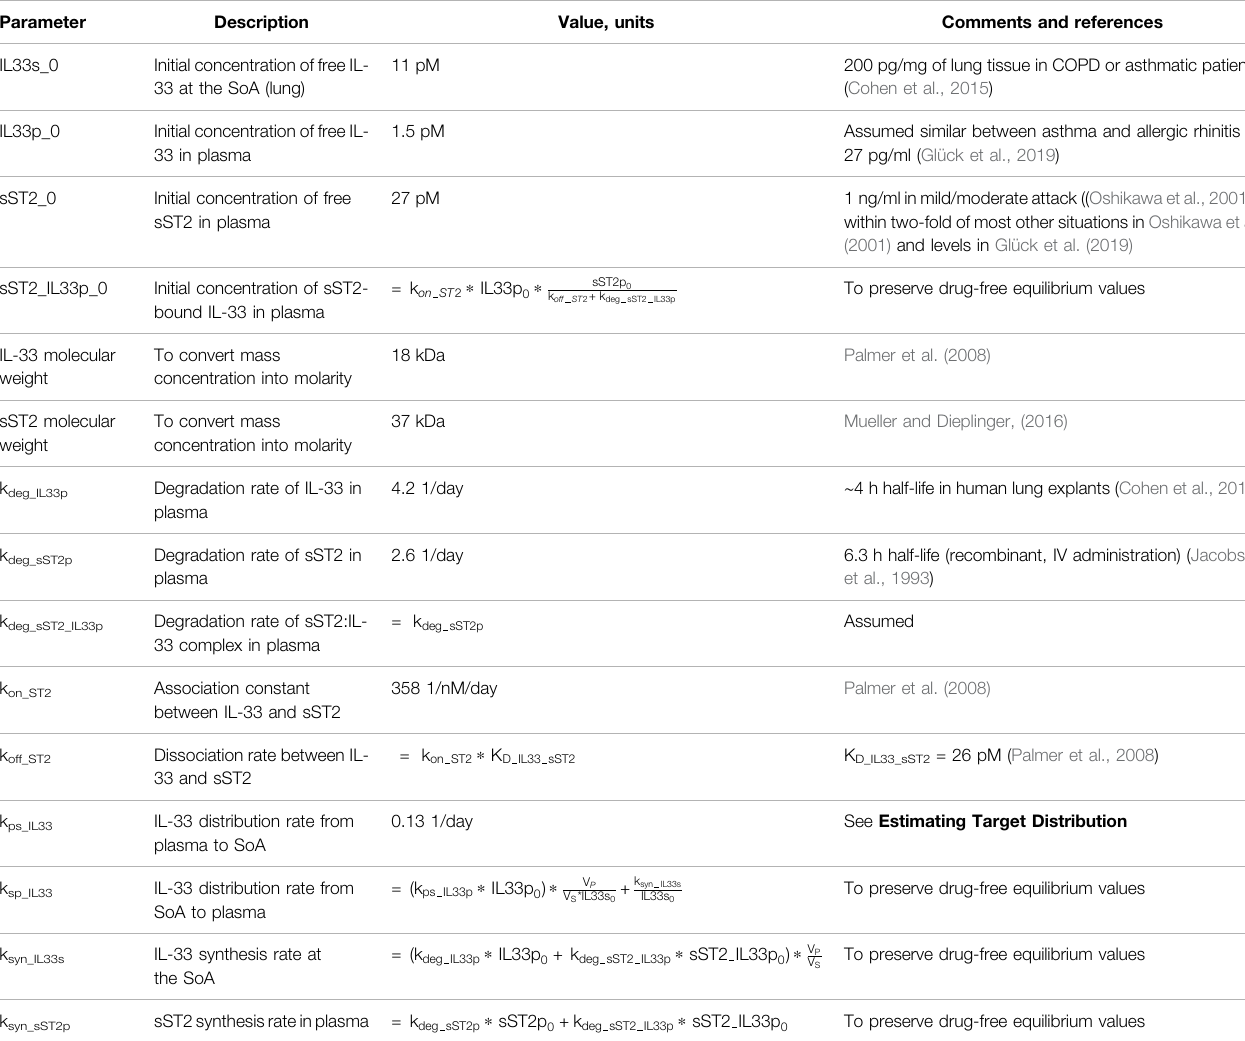
TABLE 5 | List of target-related parameters used for anti-IL-33 model.